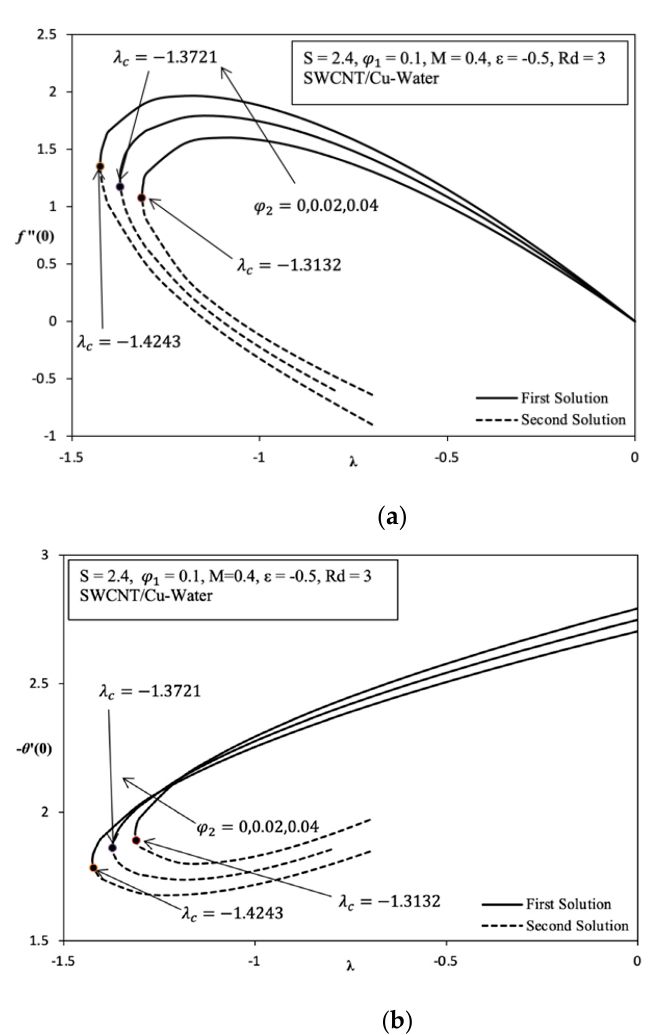
Figure 2. Variation versus λ with different values of (cid:2030) (cid:2870) for SWCNT/Cu-water when S = 2.4, (cid:2030) (cid:2869) = 0.1, M = 0.4, ε = − 0.5, Gr = 0, and Rd = 3: ( a ) Variation on f ″ (0); ( b ) Variation on − θ ′ (0). M = 0.4, ε = − 0.5, Gr = 0, and Rd = 3: ( a ) Variation on f (cid:48)(cid:48) (0); ( b ) Variation on − θ (cid:48)